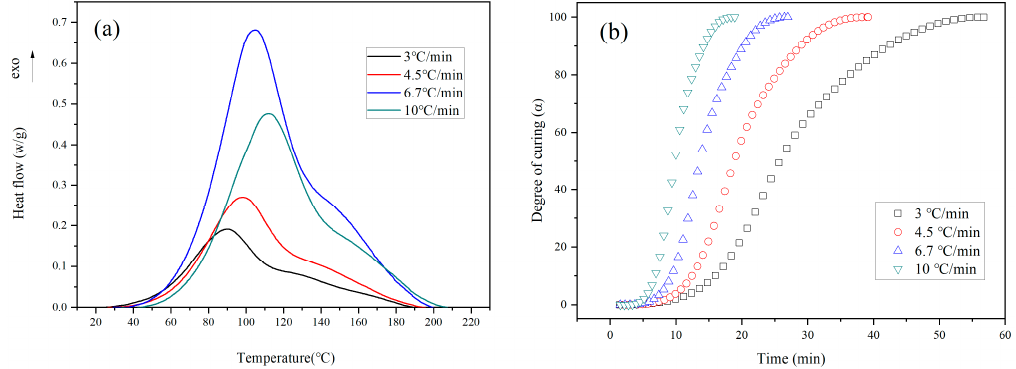
Figure 3. DSC heat flow and conversion graphs at multiple heating rates. ( a ) Heat flow against curing with different heating rates; ( b ) conversion as a function of time.